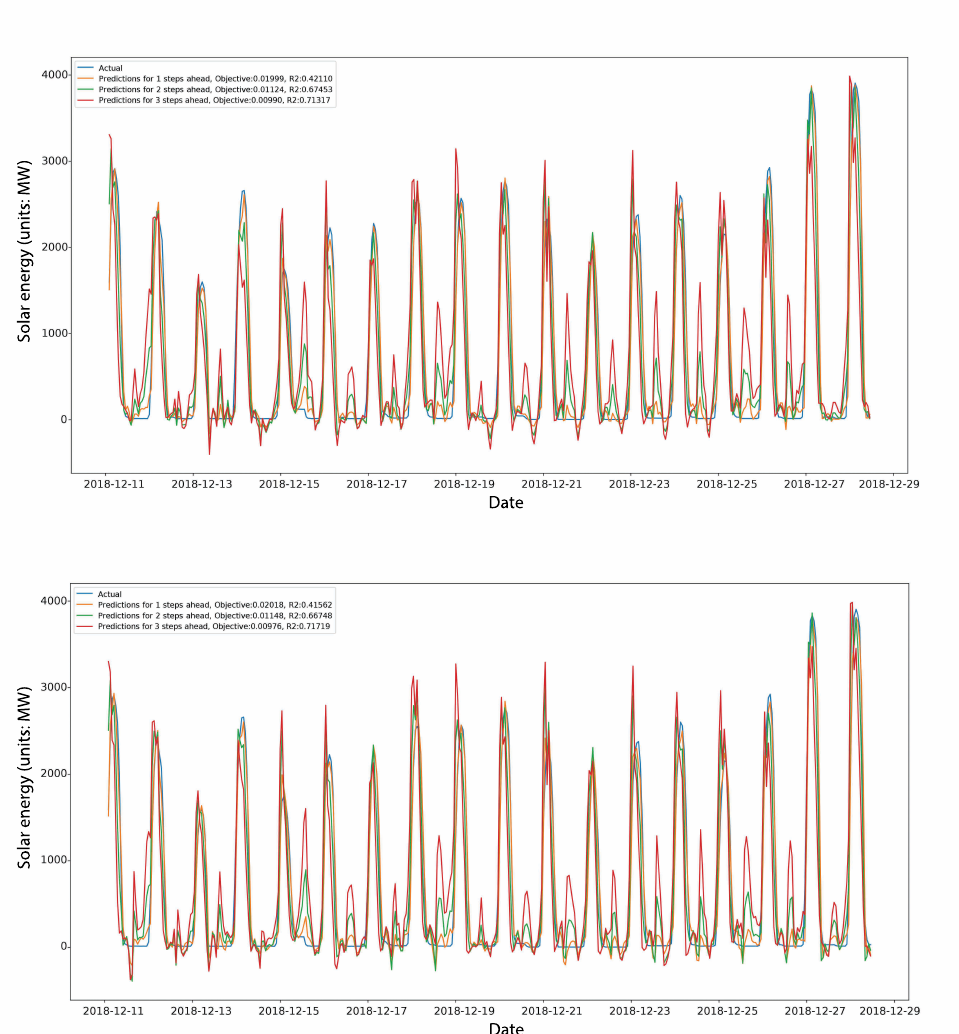
Figure 11. Graphical representation of the best predictions of the proposed BiLSTM-HRSA ( top ), compared to the best predictions of the elementary BiLSTM-RSA method ( bottom